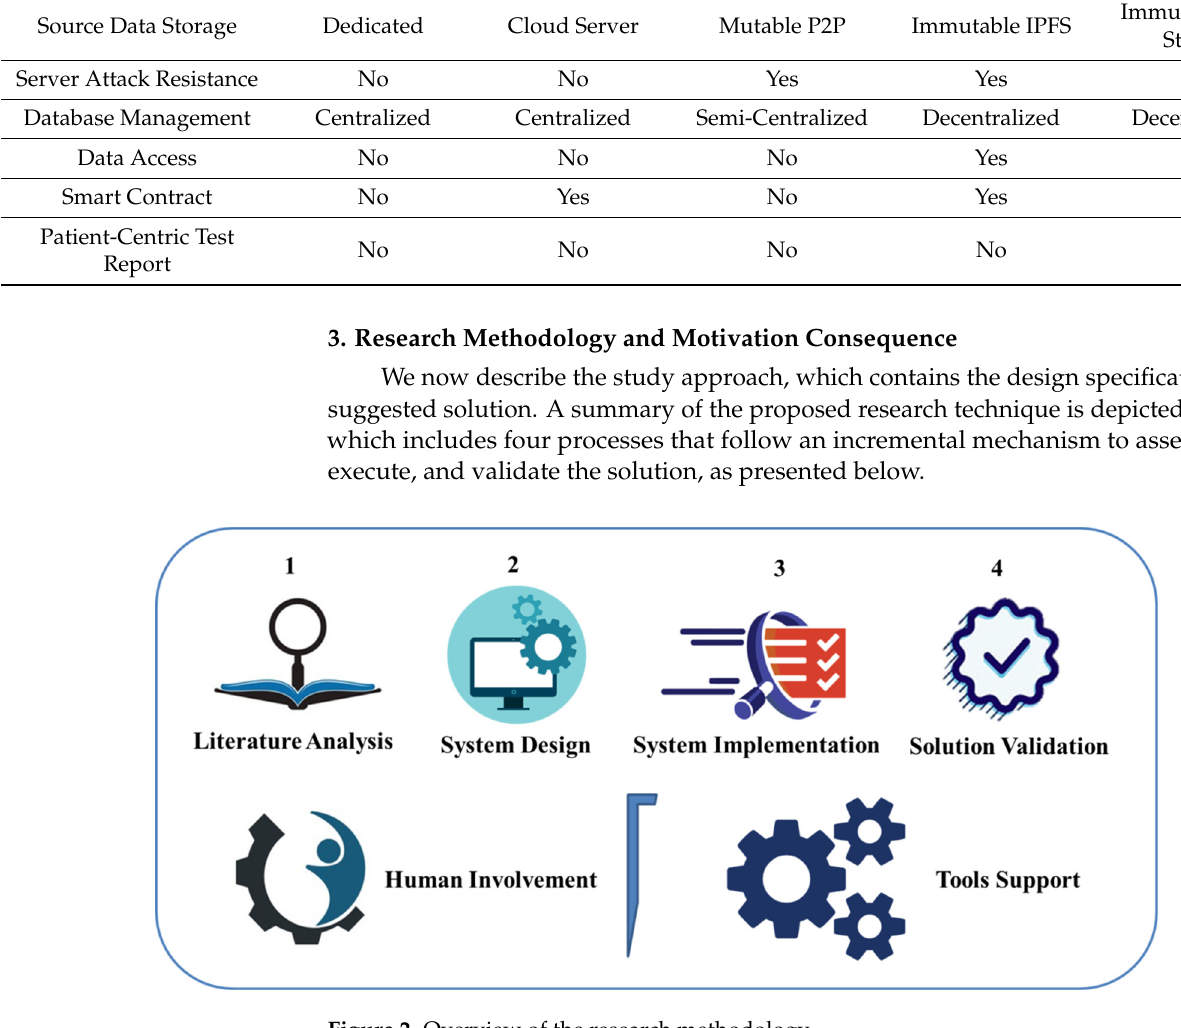
Table 1. Comparison of the proposed and existing PCRIM systems.